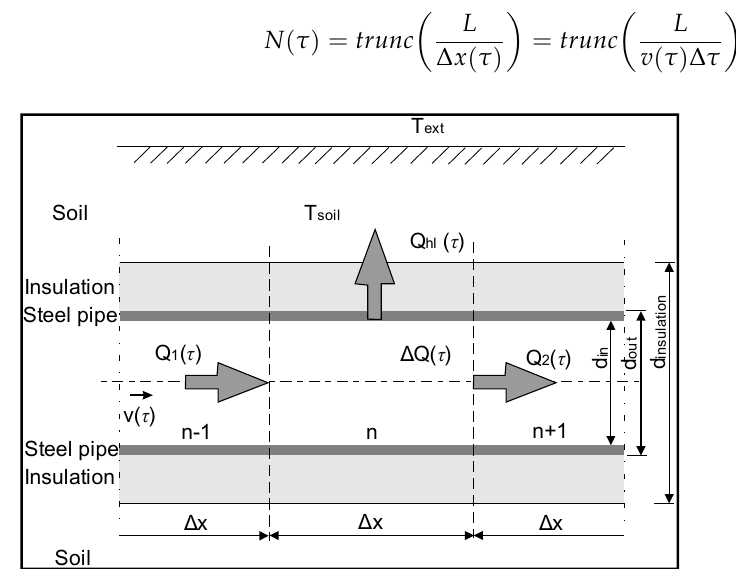
Figure 5. Model of heat transport through a district heating pipeline.